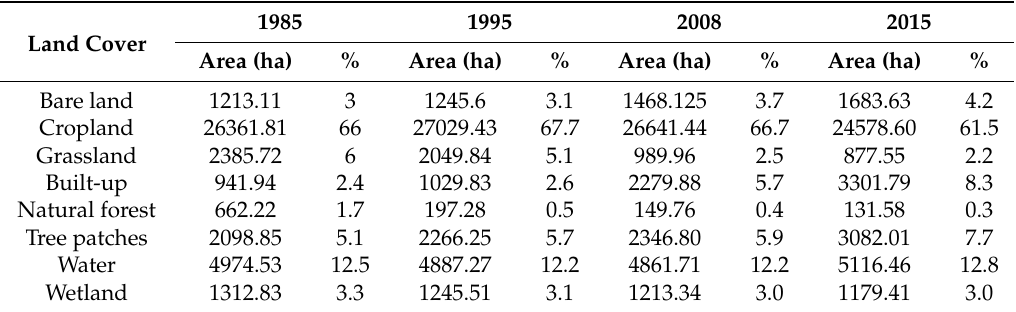
Figure 4. Land use / land cover (LULC) map of the study area. Figure 4. Land use/land cover (LULC) map of the study area. Table 4. Summaries of area of classified land use / land covers in the study area for the di ff erent Table 4. Summaries of area of classified land use/land covers in the study area for the different reference reference years.